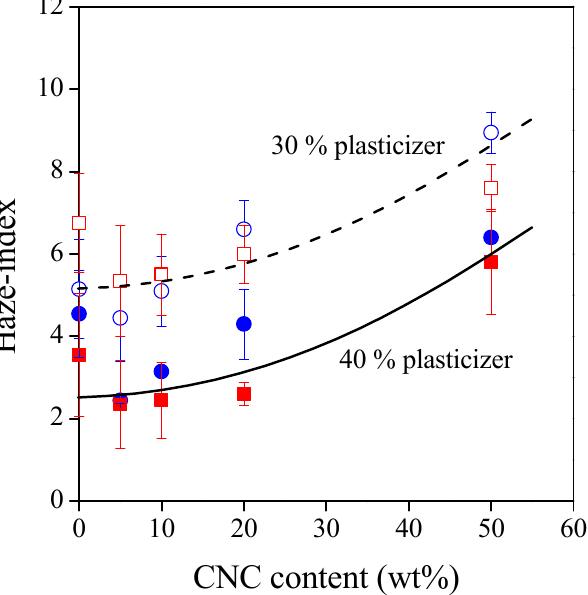
Figure 3. Haze index of TPS–CNC composites at 600 nm as a function of CNC content. Symbols: ( ) 30% glycerol; ( ) 40% glycerol; ( ) 30% sorbitol; ( ) 40% sorbitol.